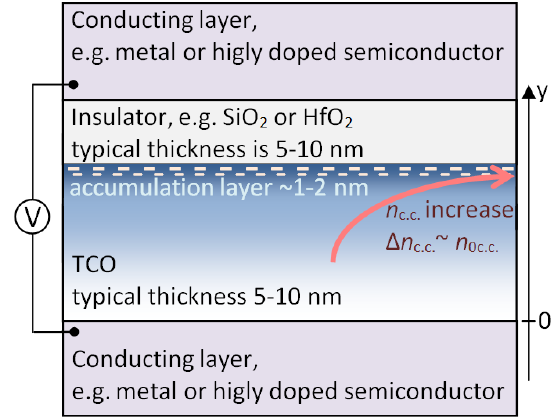
Figure 6: Schematic view of a multilayer stack: TCO and insulator layers sandwiched between electrodes. TCO: Transparent conduct- ing